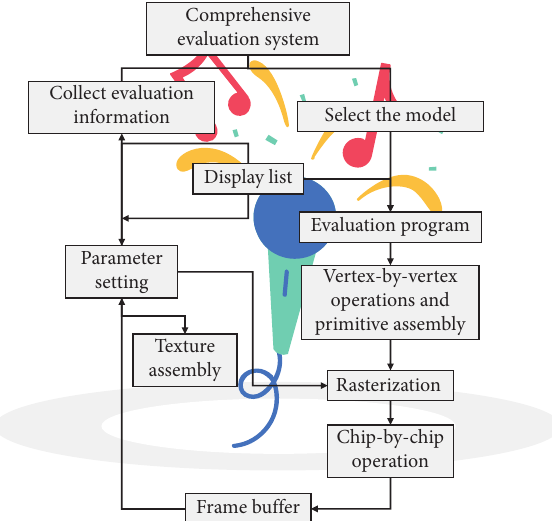
Figure 2: Flowchart of the collaborative filtering algorithm based on directed